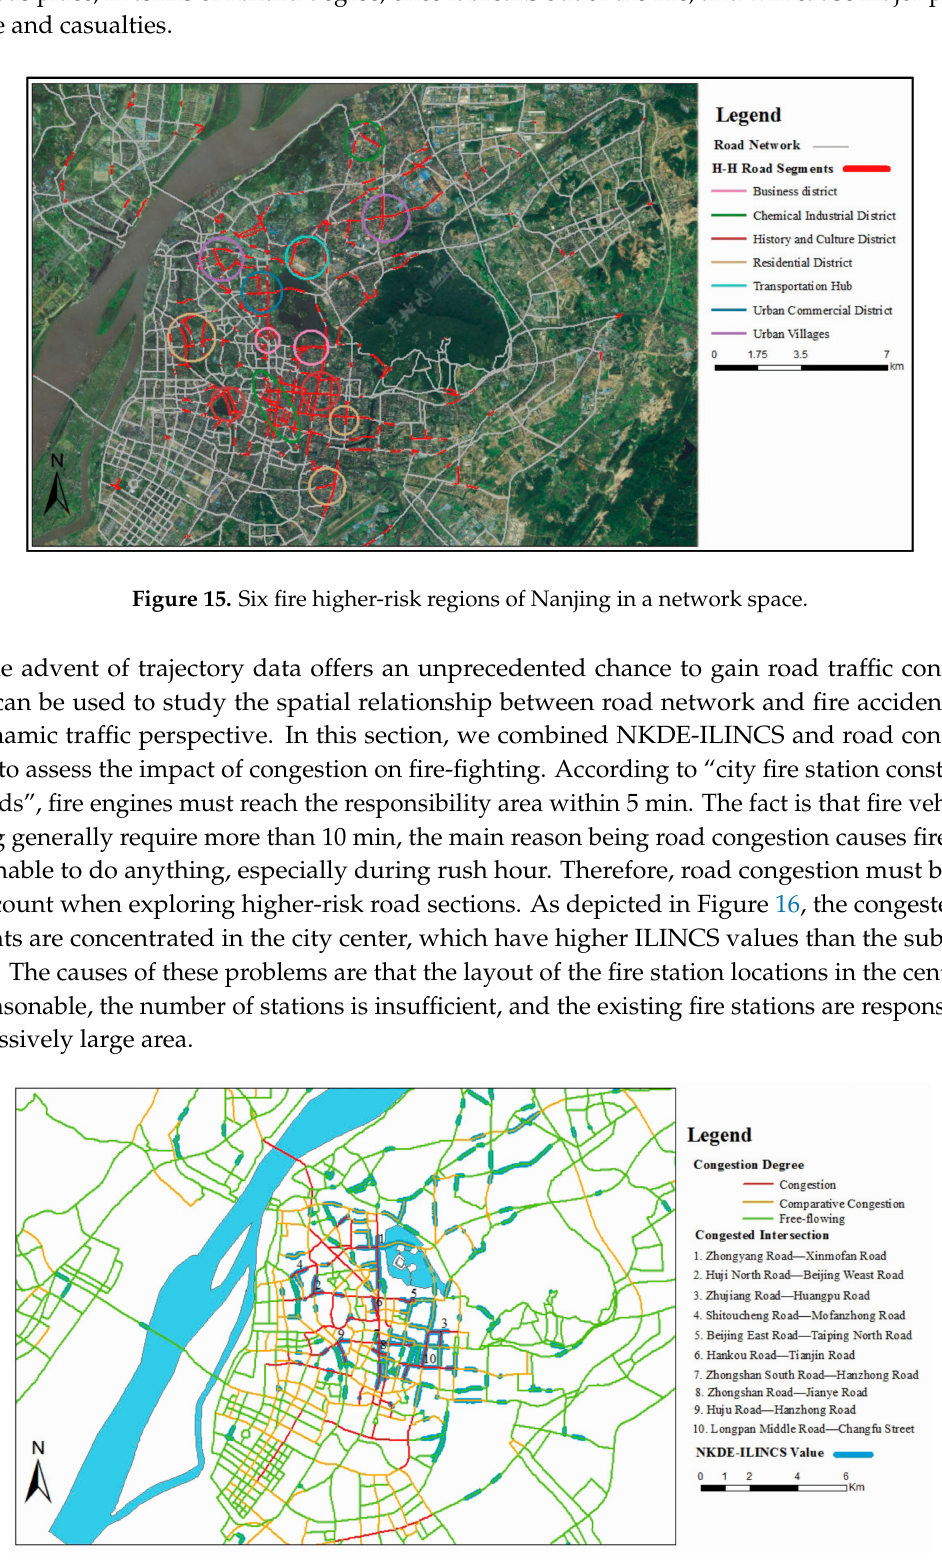
Figure 16. Road congestion degree in urban fire higher-risk